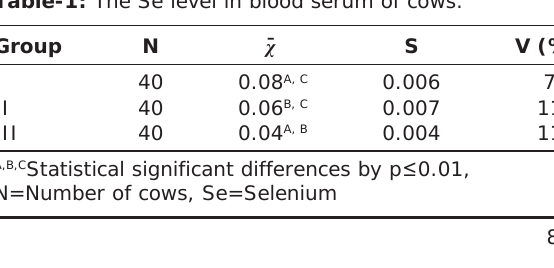
Table-1: The Se level in blood serum of